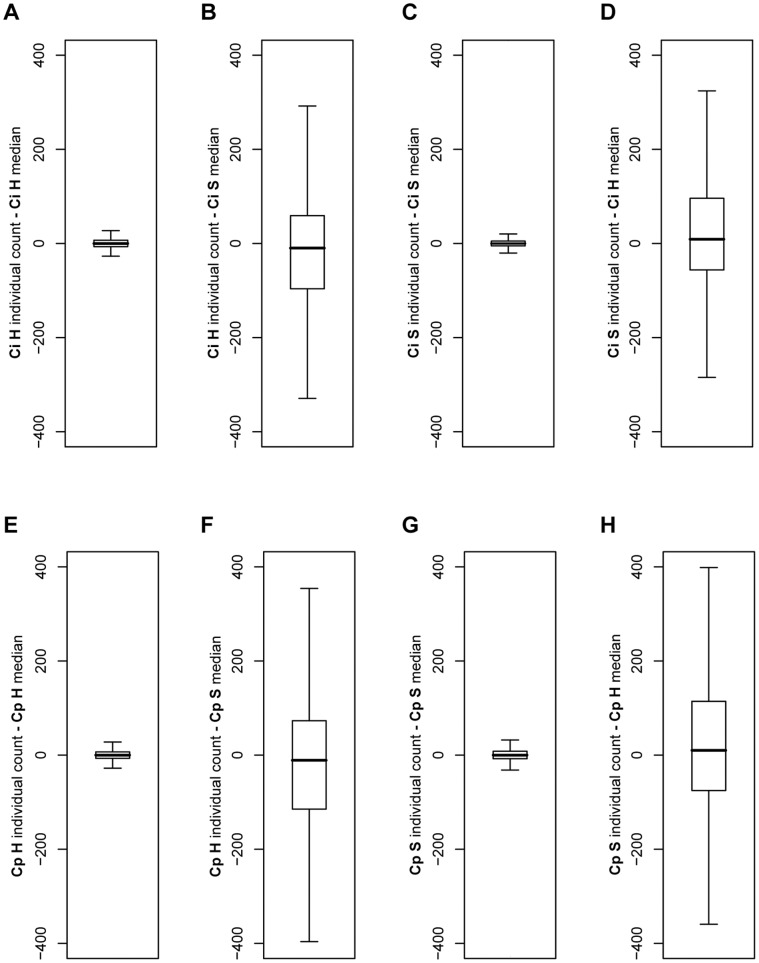
Median-difference boxplots.Median-difference boxplots showing the interquartile range (box with median line) of individual counts from the median count for all genes. Plot “whiskers” extend 1.5 times the interquartile range; outlier points are not shown. Ci: C. immitis, Cp: C. posadasii, H: hyphae (saprobic phase), S: spherule (parasitic phase).